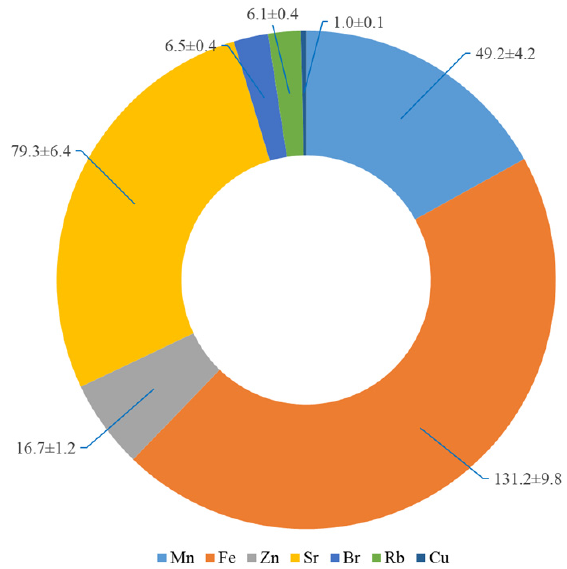
Figure 2. Content of elements in the leaves of L. maritimus , mg kg − 1 DW (July 2018).